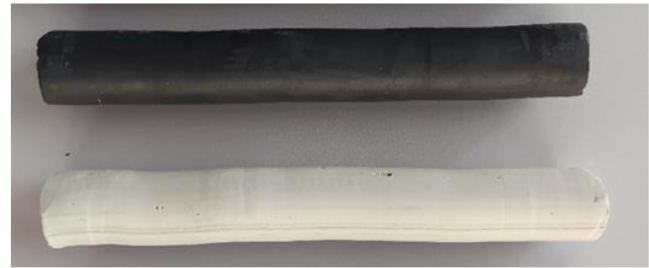
Figure 5. Samples used for model tests.